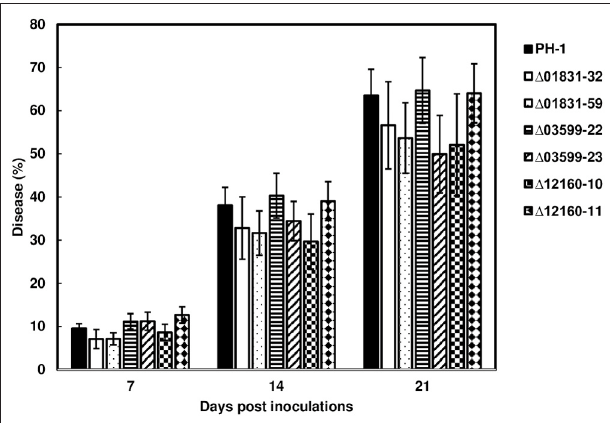
FIGURE 3 | FHB spread from the effector mutants during wheat head infection. Point inoculations (10 µ L spore suspension containing 1,000 conidia) were performed on wheat florets (cv. Norm) with F. graminearum wild-type PH-1 and mutants 1 01831-32 and 59, 1 03599-22 and 23, and 1 12160-10 and 11. FHB disease progression was measured by the percentage of florets infected at 7, 14, and 21 days post inoculation (dpi). Bars represent the average percentages and standard error of infected spikelets with each strain. Means at each timepoint were analyzed independently and compared to the control PH-1 by on one-way analysis of variance (ANOVA) and Dunnett’s test using JMP ( N = 20; P > 0.05).